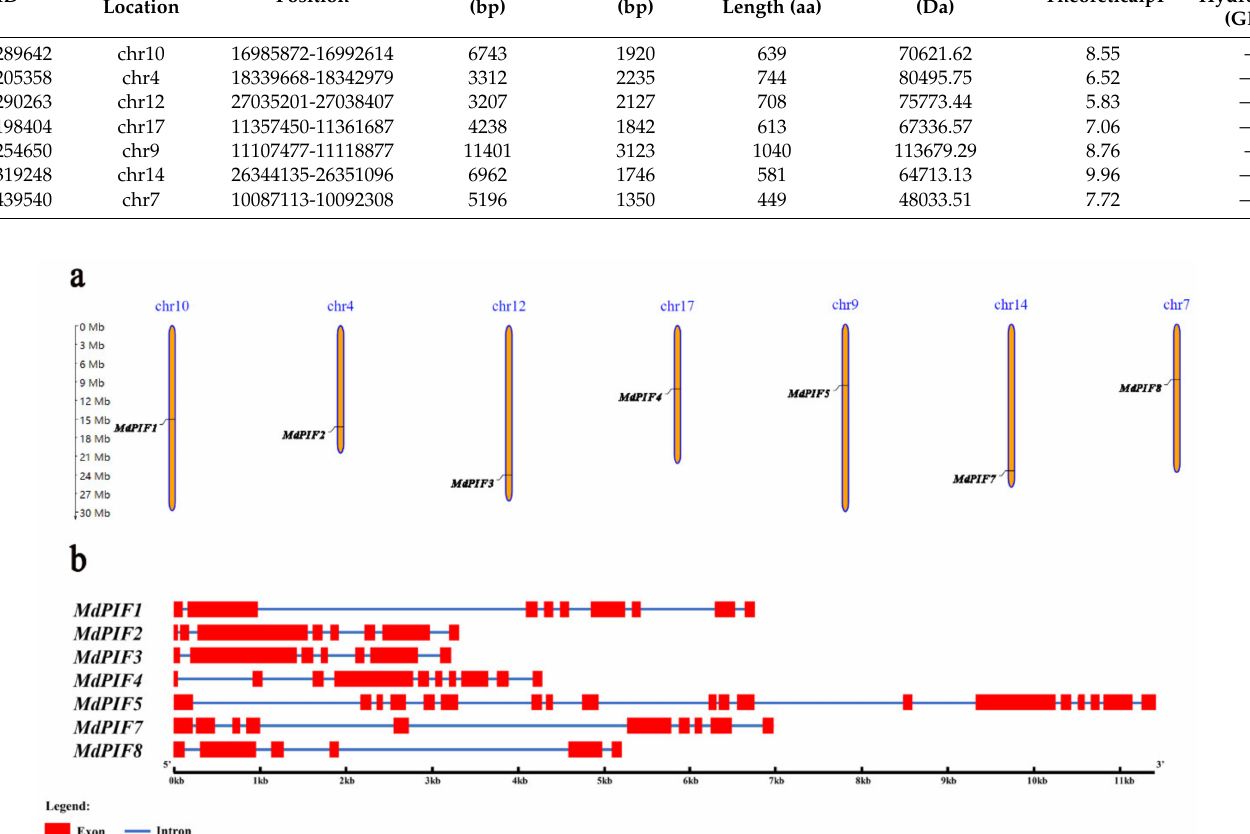
Figure 1. Chromosomal location and gene structure (intron / exon) of the MdPIF genes. ( a ) Chromosomal location of seven MdPIF genes on seven apple chromosomes. ( b ) Gene structures of the MdPIF genes. Red boxes indicate exons and blue lines indicate